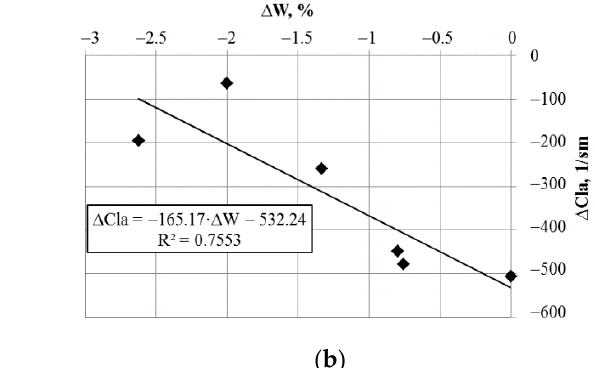
Figure 4. Coefficient of light absorbance variation vs oil production rate ( a ) and change of water cut of produced product ( b ) [101].